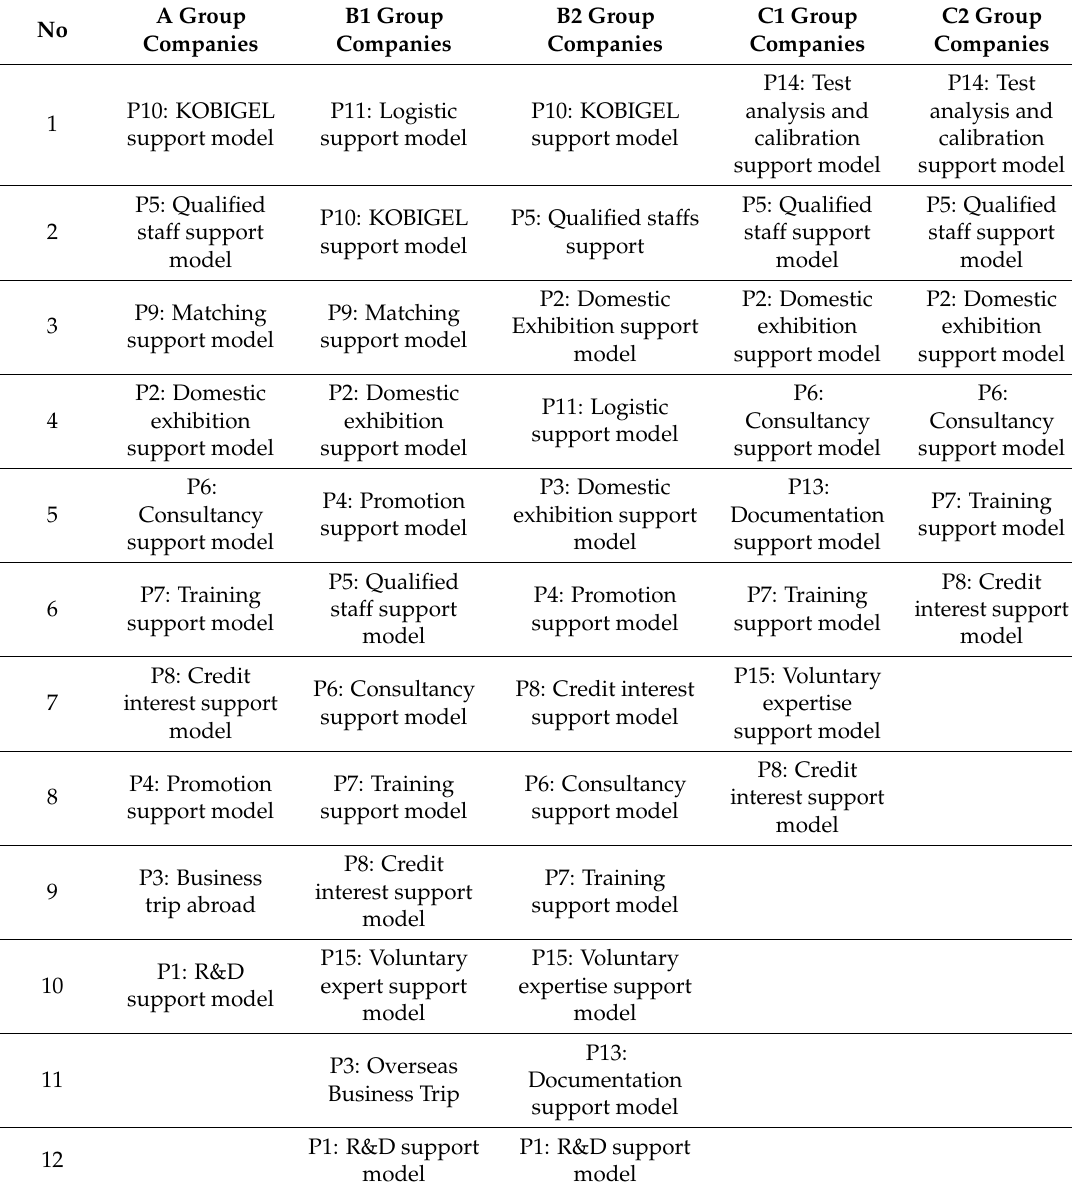
Table 8. Priority Small and Medium Enterprises Development and Support Administration KOSGEB upport models proposed for Group A, B1, B2, C1, and C2